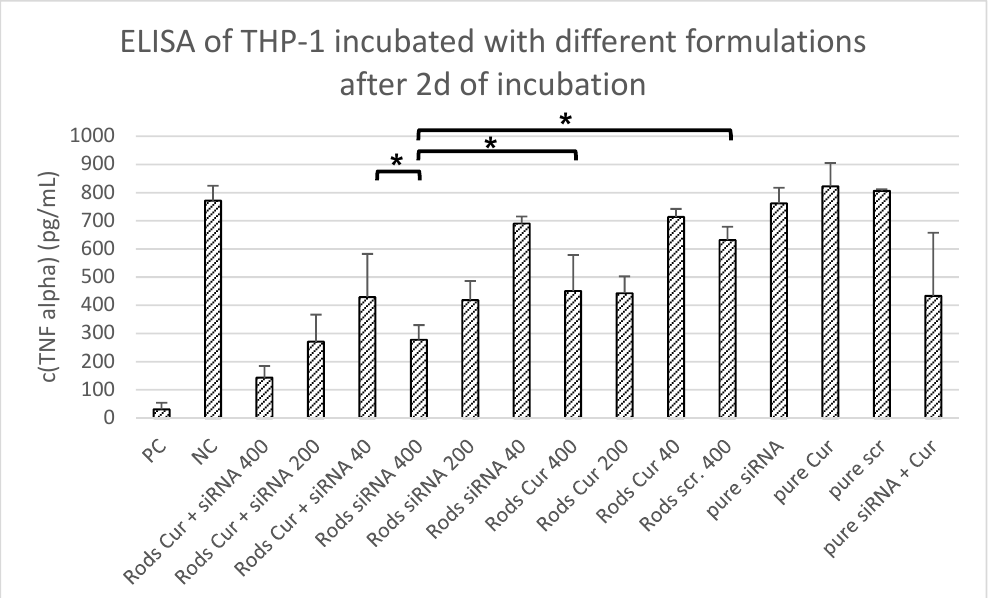
Figure 5. Determination of TNF- α release after incubation with different formulations for 48 h followed by LPS stimulation. As NC, cells were stimulated only with LPS without any carrier system, whereas the PC represents unstimulated cells. In order to compare the microrods loaded with both active ingredients (Rods Cur+siRNA) and the individually loaded microrods, a formulation containing only curcumin (Rods Cur) and only siRNA (Rods siRNA) were prepared and its influence on cytokine release determined. To exclude possible unspecific gene silencing by an oligonucleotide sequence, a scrambled siRNA with the same number of base pairs was used as an additional control. In addition, the drugs were applied to the cells without a carrier system to show the influence of the microrods as a means of transport. The results obtained show that the formulation with both active ingredients can significantly reduce the TNF- α release in contrast to the formulations with just one drug, or the active ingredients without carrier. Moreover, no unspecific inhibition by scrambled siRNA was observed. However, it can also be seen that all microrod formulations can inhibit cytokine release, which shows that the cylindrical microparticles can effectively transport the active ingredients into the macrophages. Significance of the obtained data was calculated by two-sided Student’s t -test. * p < 0.05.